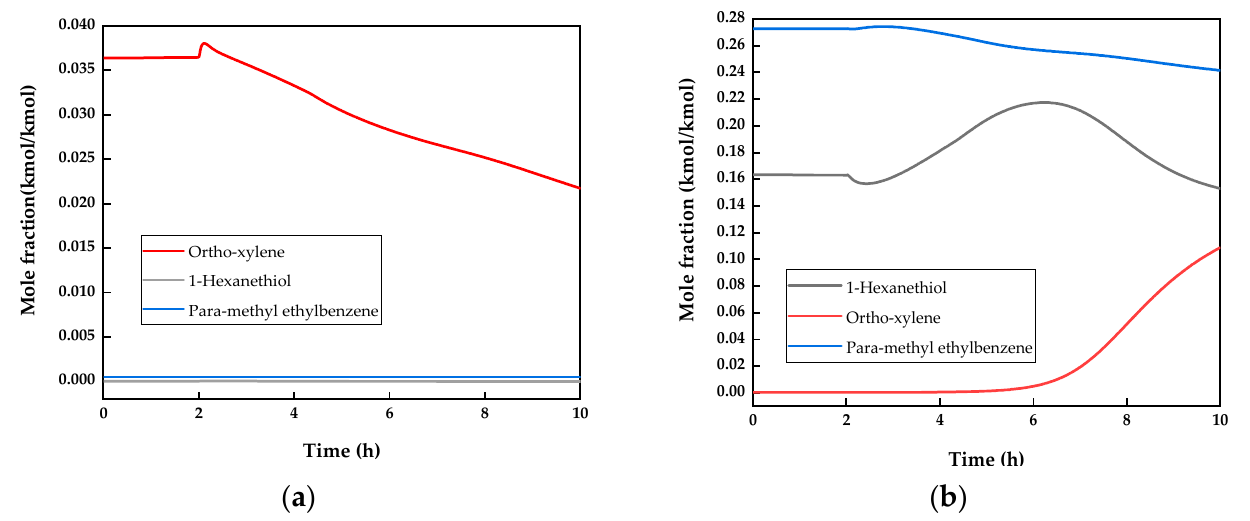
Figure 11. Three key components in stream: ( a ) Top-out2; ( b ) Bot-out2. All relationships of node variables in the hydrogenation prefractionation system are analyzed by mechanism and process data similarly. Moreover, the listed influence relationships are combined into a complete SDG model. The obtained SDG model of the hydrogenation prefractionation system is shown in Figure 12. All nodes are connected by solid arrows or dotted arrows, which mean the positive or negative correlation among variables. To retain the most accurate features of the faults, the SDG model is appropriately simplified by reducing unnecessary arcs.